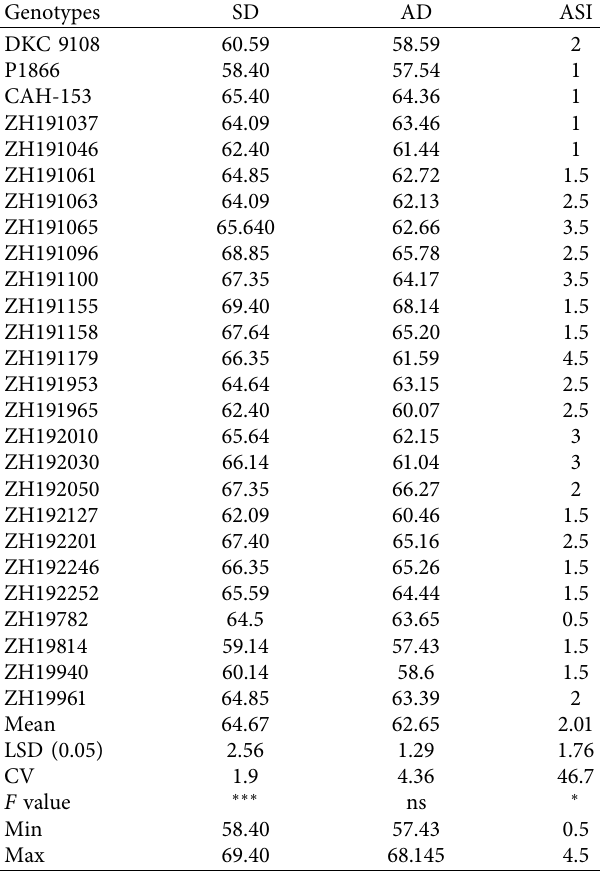
Table 4: Reproductive trait performances of